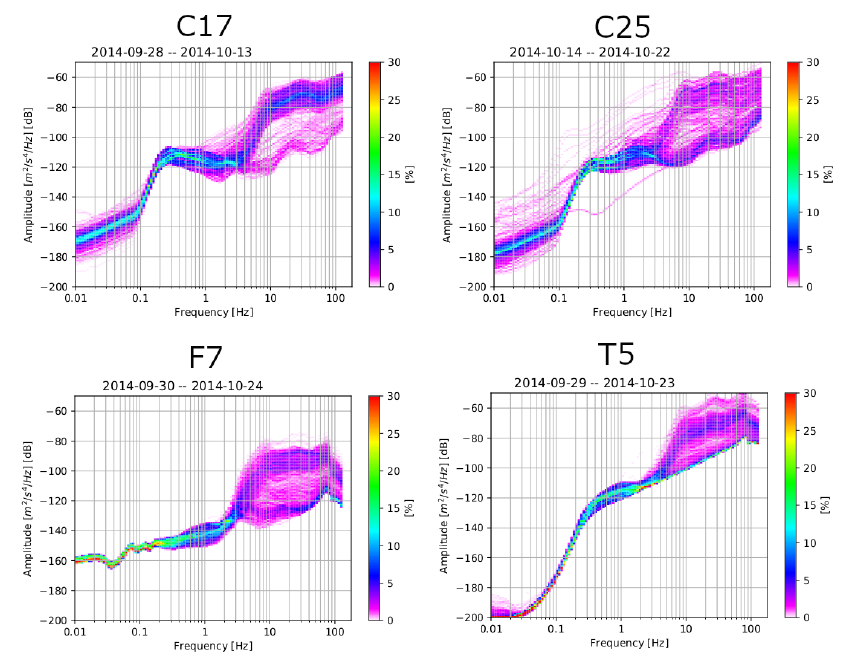
Figure 2. Initial analysis of noise data: every individual curve gives the power spectral density (PSD). Color bars display the probability of distribution of seismic power spectral density at different frequencies. Every plot represents the vertical component of one station (station ID at the top) during the entire recording time. Both high amplitudes and low signal variability can be observed mostly between 0.1 and 3